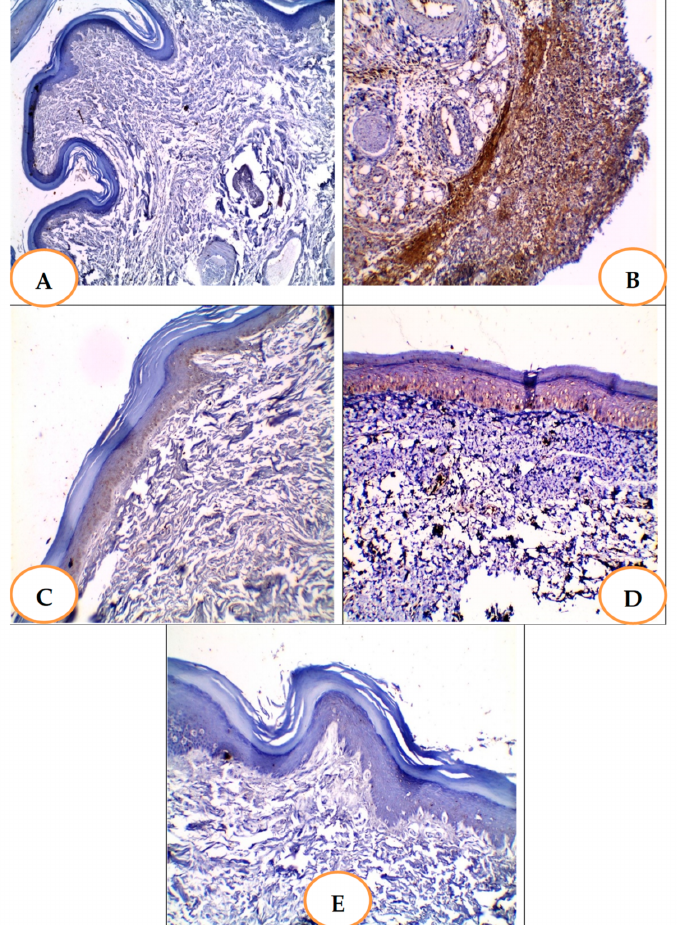
Figure 7. Effects of different treatments on immune histochemical staining of COX-2 in paw